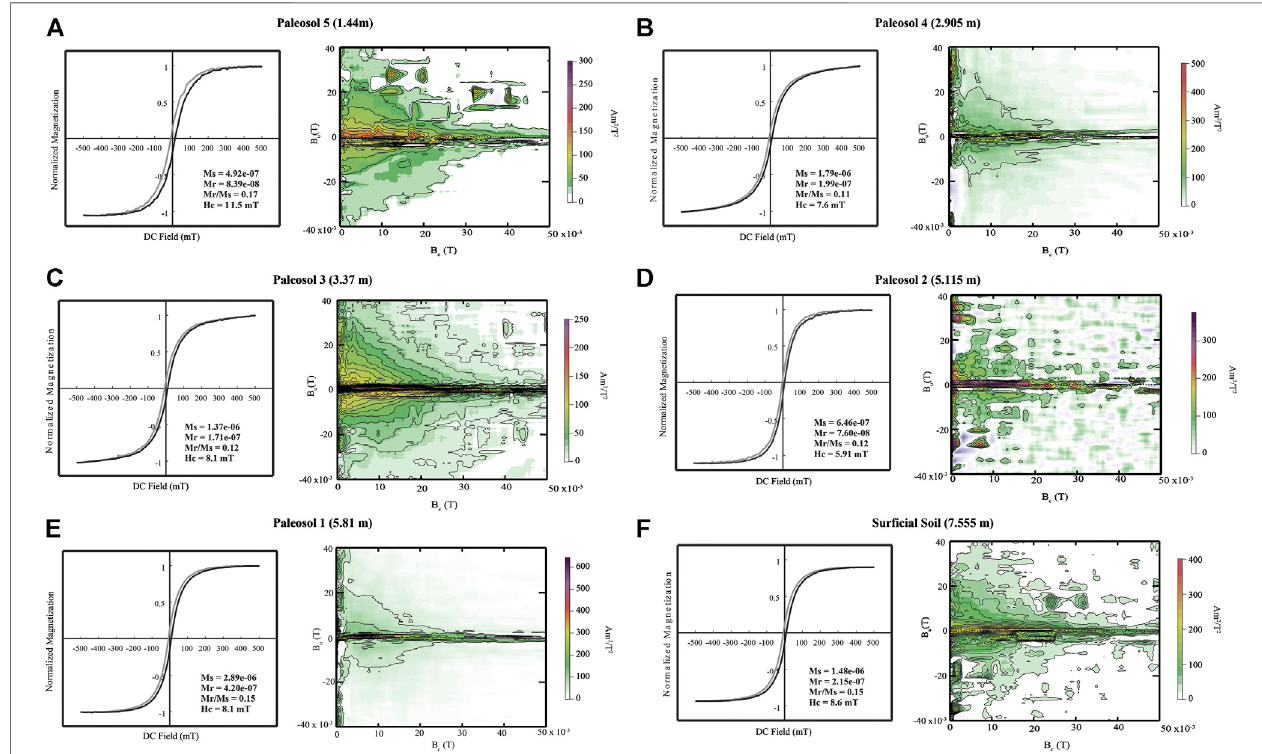
FIGURE 11 | Normalized hysteresis curves, after correction for any paramagnetic contribution, and First-Order-Reversal-Curves (FORC(s)) of representative samples from all fi ve paleosols and the Sur fi cial Soil. Figure 10A-F correlates respectively to Paleosols 5- Sur fi cial Soil. For the hysteresis curves note the narrow loops and low coercivity values (5-10 mT), which indicate the dominance of low to moderate coercivity ferrimagnetic phases (Tarling, 1983; Thompson and Old fi eld, 1986; Tauxe et al., 2002; Tauxe, 2010). For the FORCs, the weak magnetization of all 6 specimens resulted in (i.e., the vortex structures present over the central ridge in Paleosol 5 and the Sur fi cial Soil). Nevertheless, all FORCs show a central ridge which indicates the presence of SD magnetic phases, while the spread of contours from thecentralridgeindicatesthepresenceofPSDphases(Robertsetal.,2000,2014;MuxworthyandDunlop,2002;Eglietal.,2010;Egli,2013;EgliandWinklhofer,2014; Ao et al.,